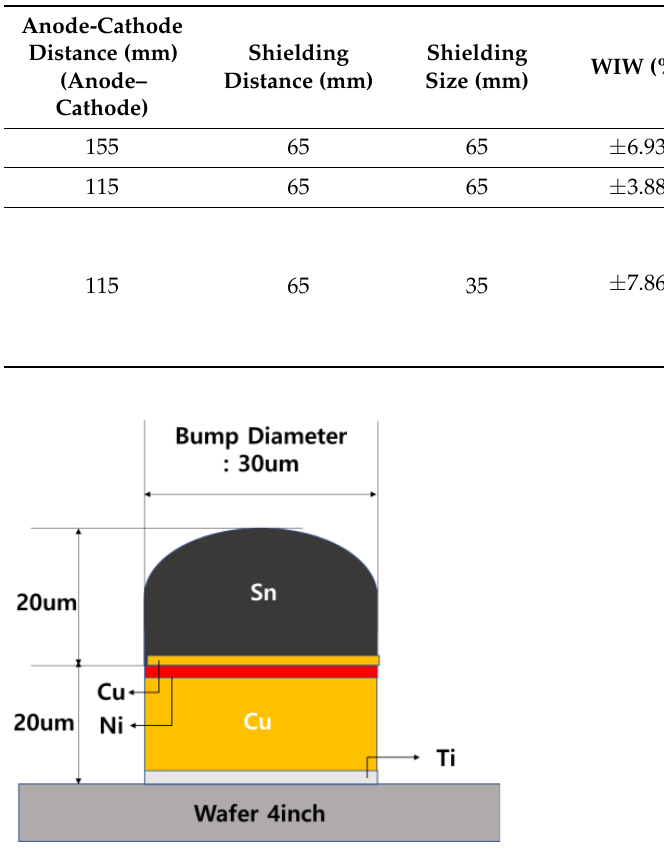
Table 7. Results of Deviation of Sn Plating Thickness on 4-inch Wafers.